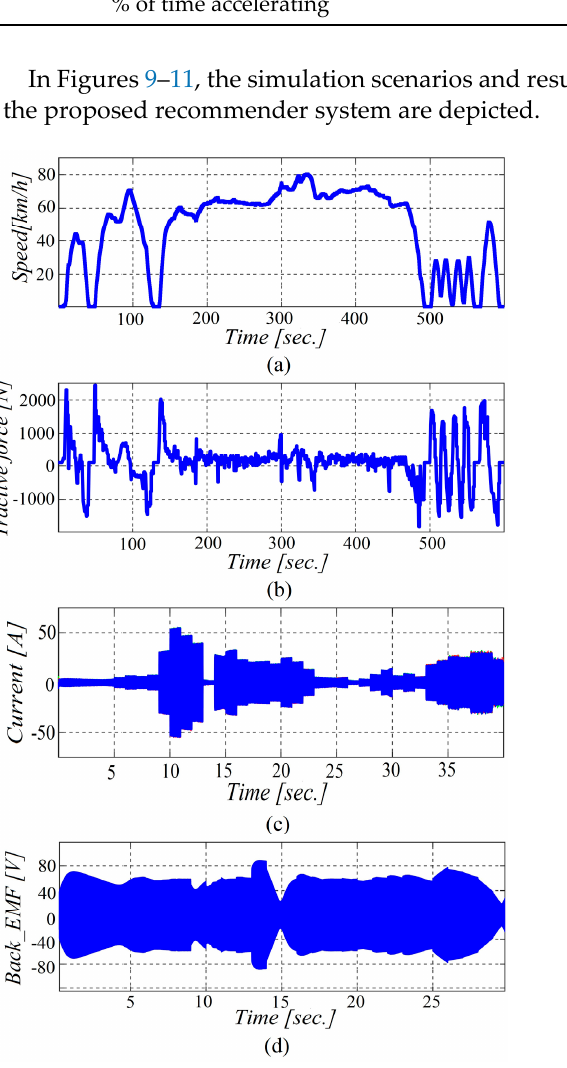
Figure 9. Simulation results without the utilization of the proposed recommender system. ( a ) Waveform of the US06 drive cycle ( b ) tractive requirements ( c ) PMSM Phase current ( d ) PMSM back-EMF.